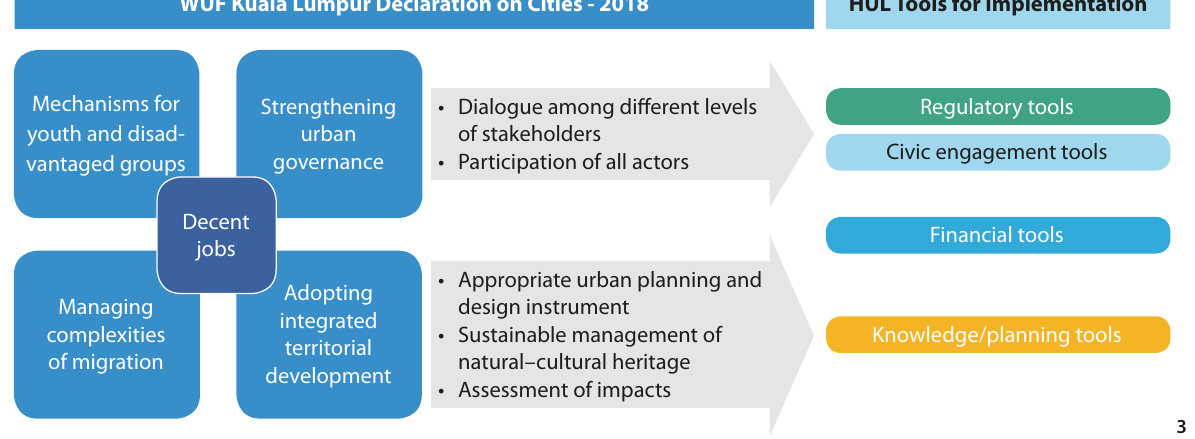
Figure 3 Links between Kuala Lumpur Declaration on Cities and HUL tools (Source: the